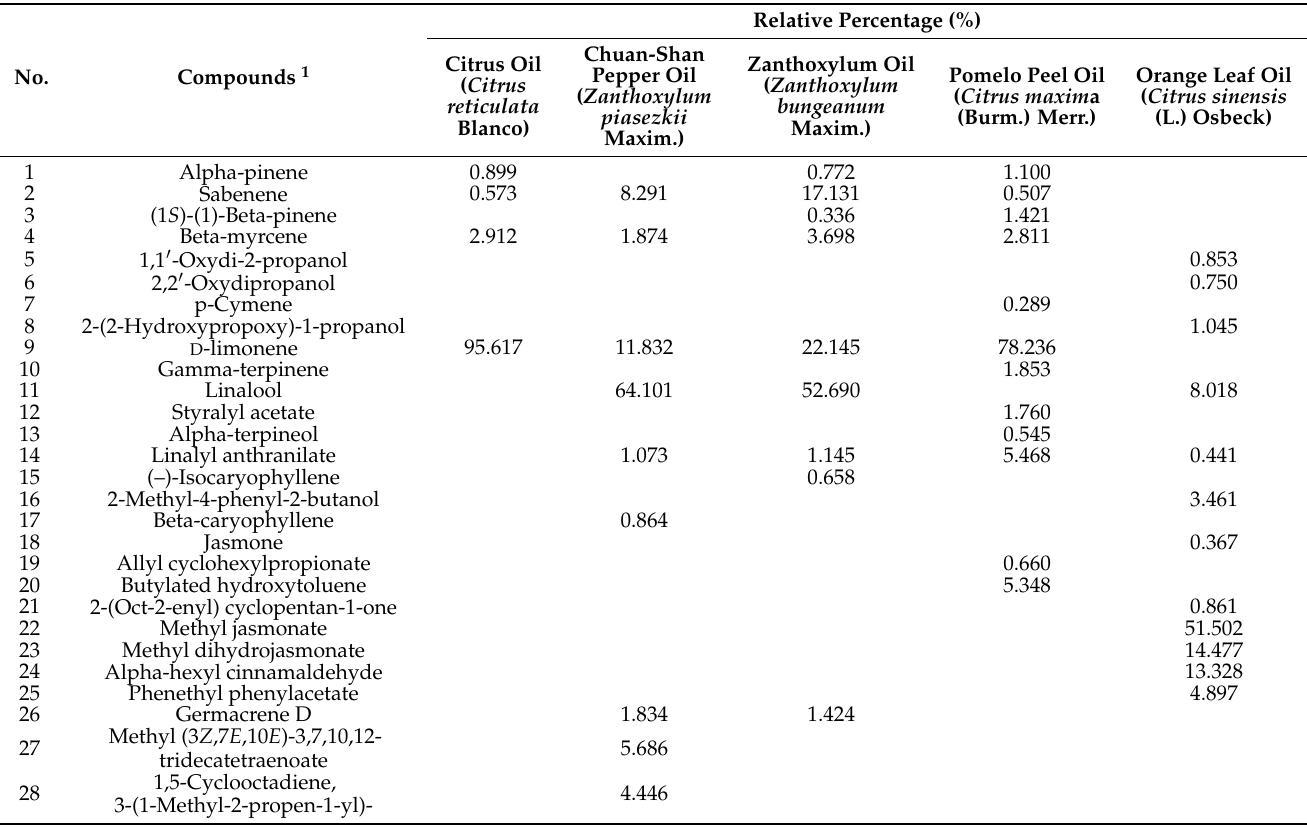
Table 1. Chemical constituents of five Rutaceae essential